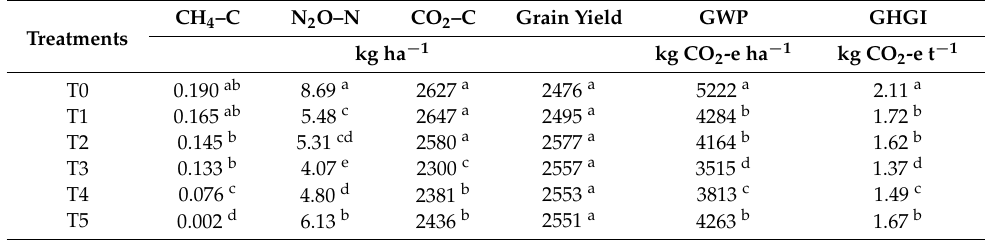
Table 3. Grain yield and total cumulative GHG emissions estimated over the entire growing season, and global warming potential (GWP) and greenhouse gas intensity (GHGI) of rain–fed spring wheat under different biochar amendment